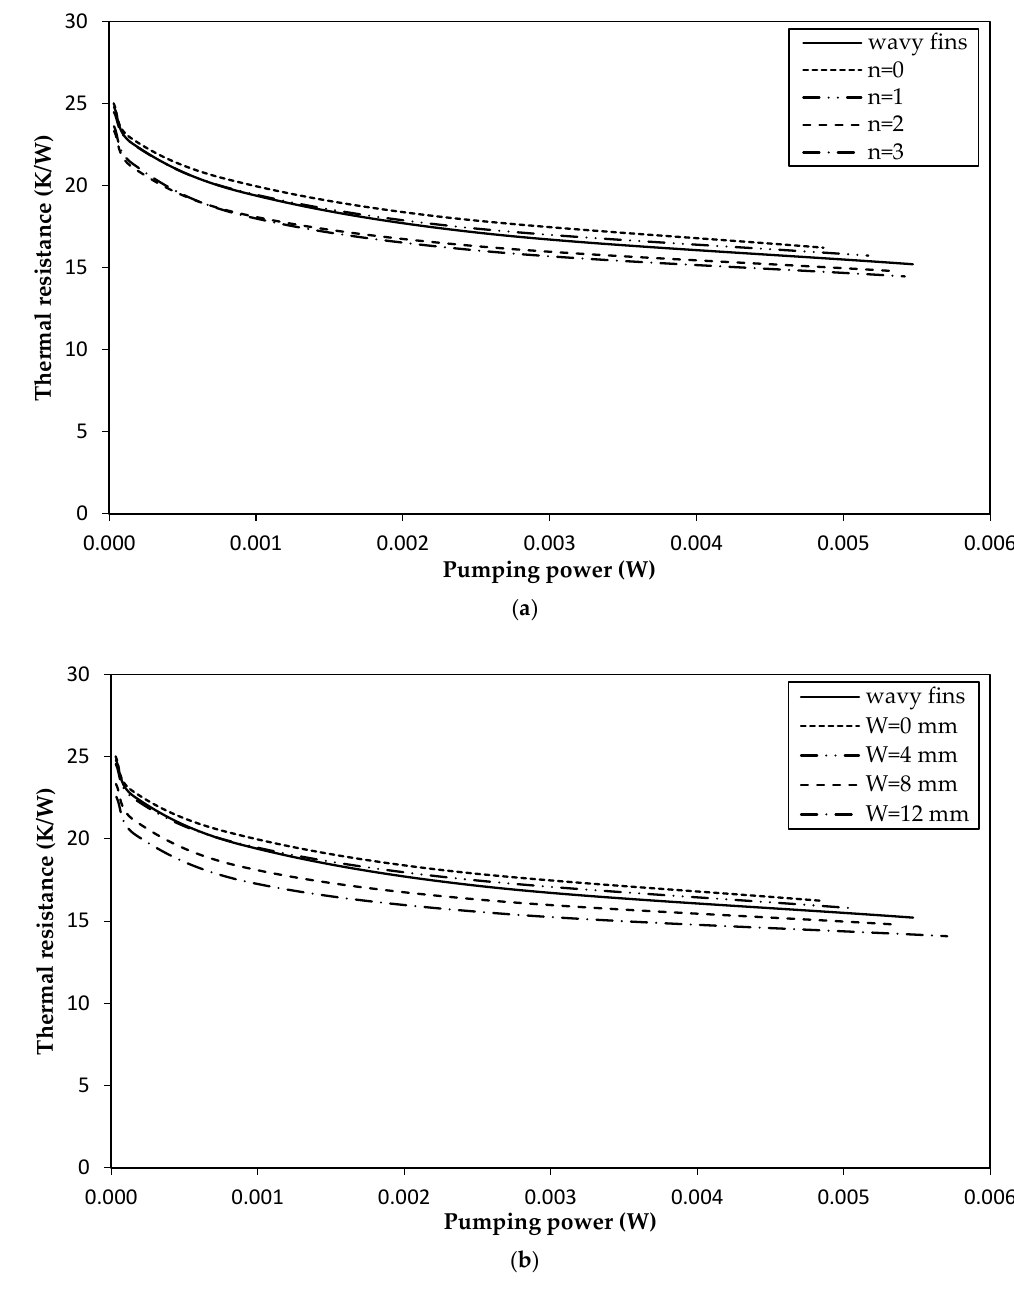
Figure 8. Thermal resistance vs. pumping power in combination of louver, flat and wavy fins: ( a ) Different number of louvers ( W = 8 mm, θ = 9 ◦ ); ( b ) different widths of louvers ( n = 2, θ = 9 ◦